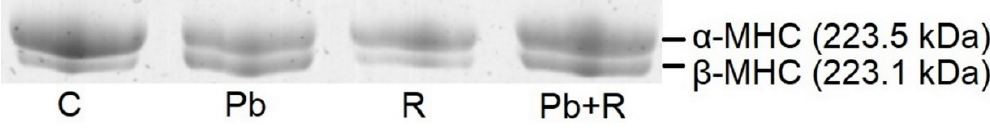
Figure 10. Representative examples of electropherograms showing the ratio of α - and β -MHC extracted from the RV rat myocardium. Left to right: “Control”; “Pb”; “Running”; “Pb + Running”.